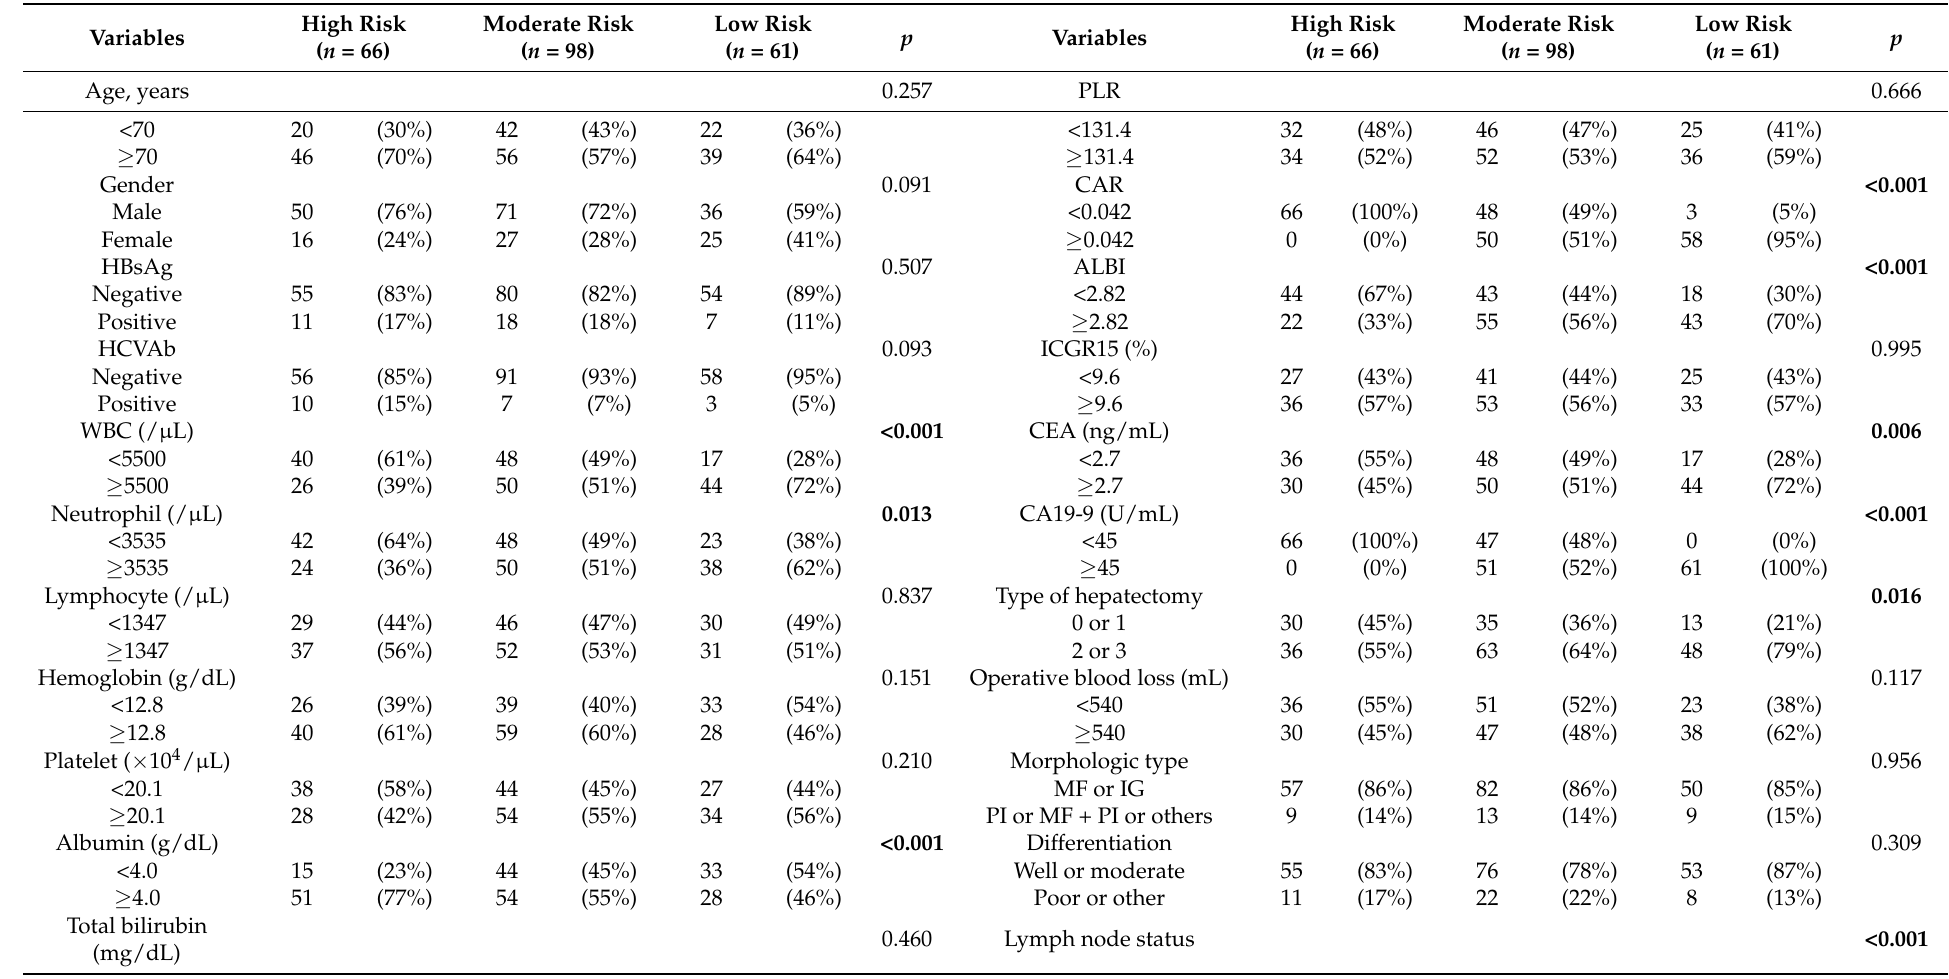
Table 1. Differences in clinical characteristics of 225 patients with intrahepatic cholangiocellular carcinoma classified into three risk groups by preoperative